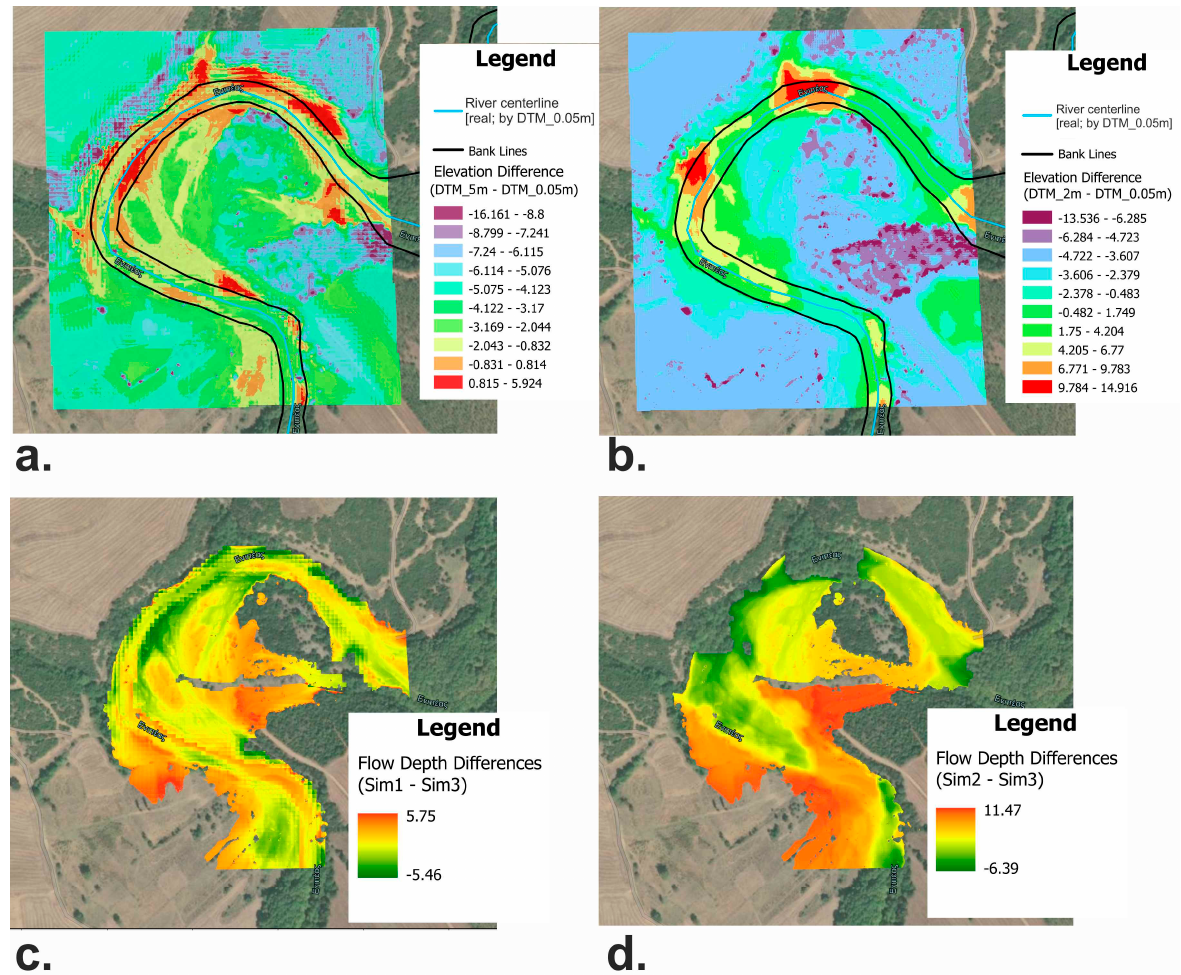
Figure 12. A section of the “flood area” (meandering) presenting differences in elevation ( a ) DTM_5 m vs. DTM_0.05 m, ( b ) DTM_2 m vs. DTM_0.05 m and flow depths for ( c ) Sim 1–Sim 3 and ( d ) Sim 2–Sim 3.